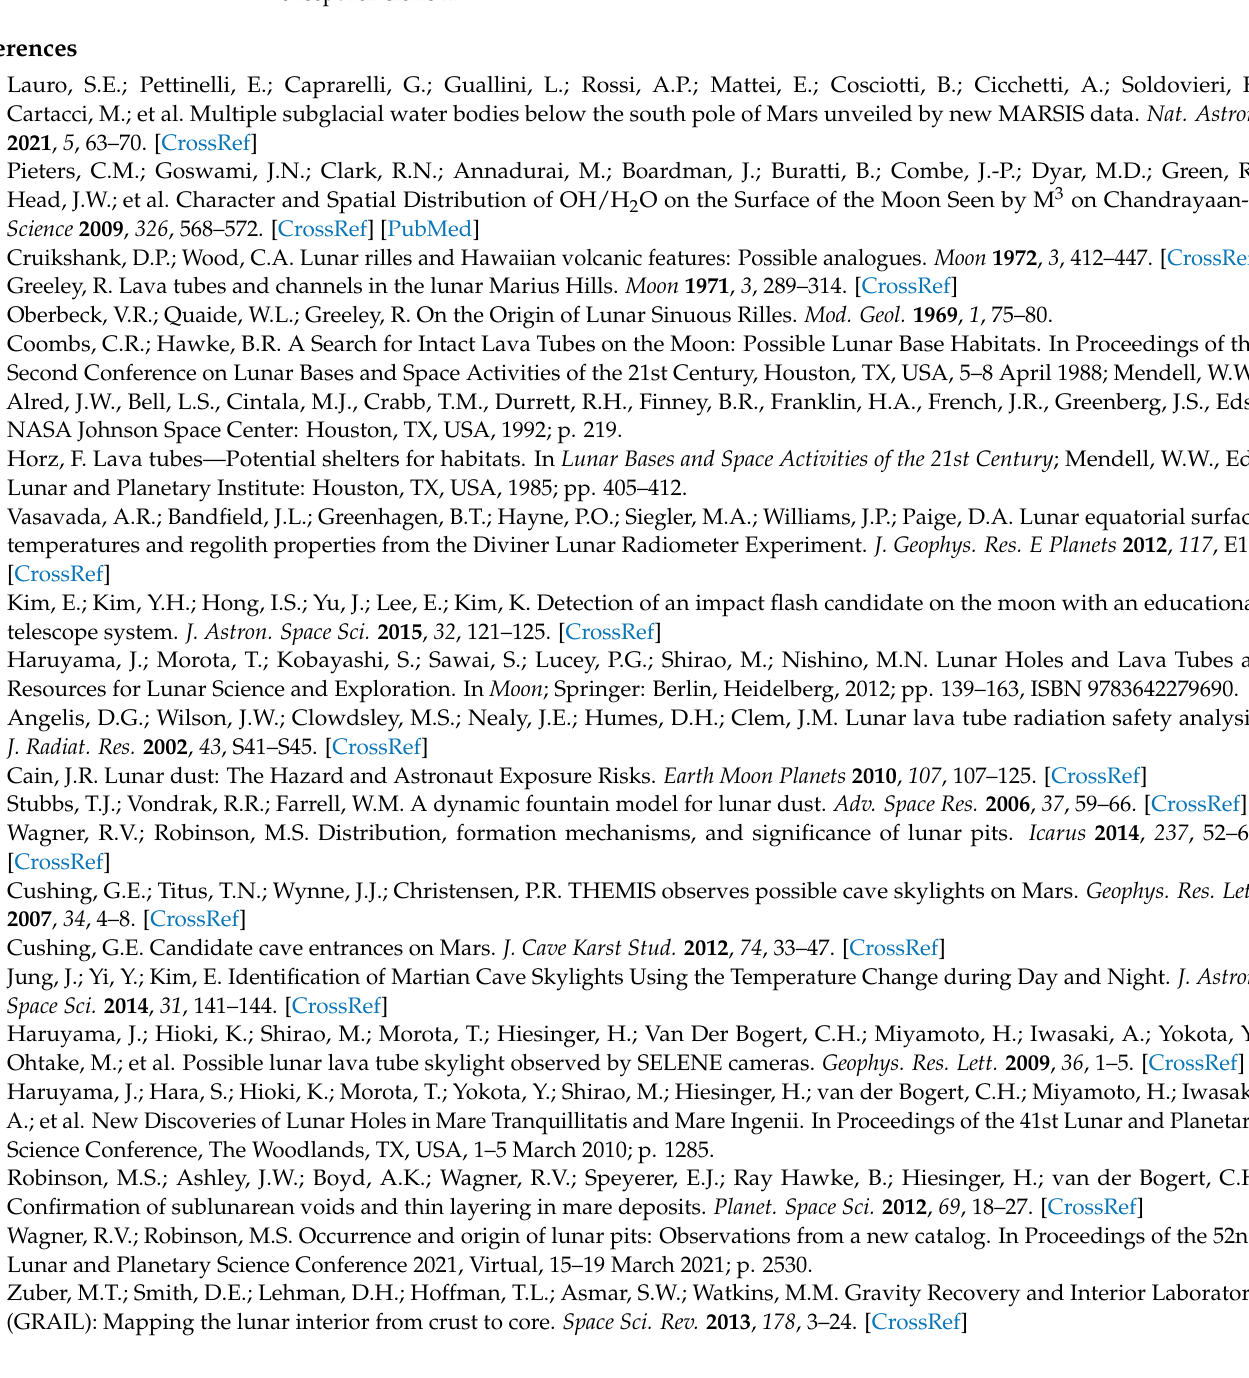
Figure A3. Clone model analysis of Marius Hills region. Five were randomly selected from among 100 clone models. The plot is normalized at order 460 for trend change visibility. The five clones of green have a similar pattern to Figure 4b. Red (MHH) can be said to be almost the same as Figure 4b, except for clone 2.